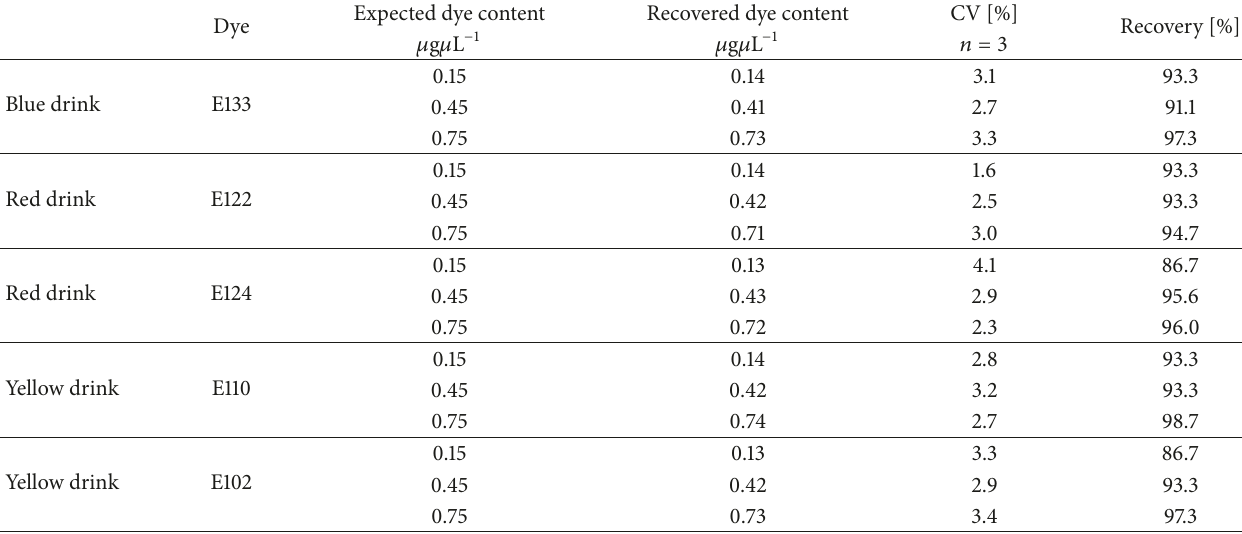
Table 4: Dye contents in spiked preparations determined by